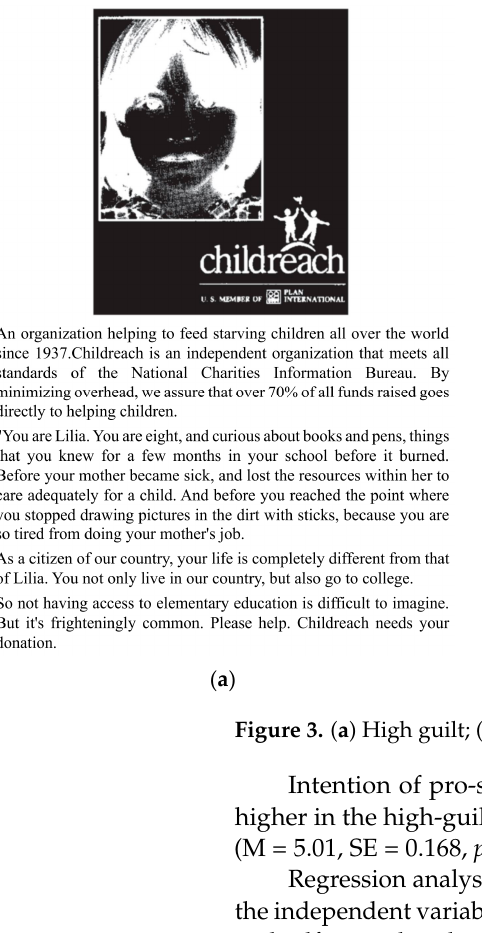
Figure 3. ( a ) High guilt; ( b ) Low